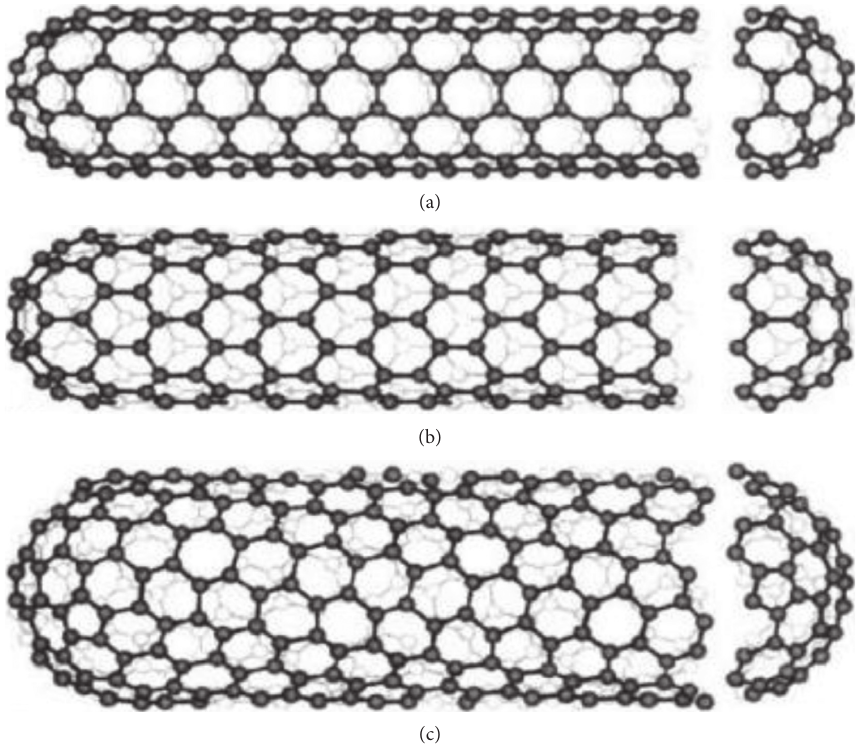
Figure 1: Different chiralities of CNTs: (a) armchair; (b) zig-zag; (c) chiral [13].